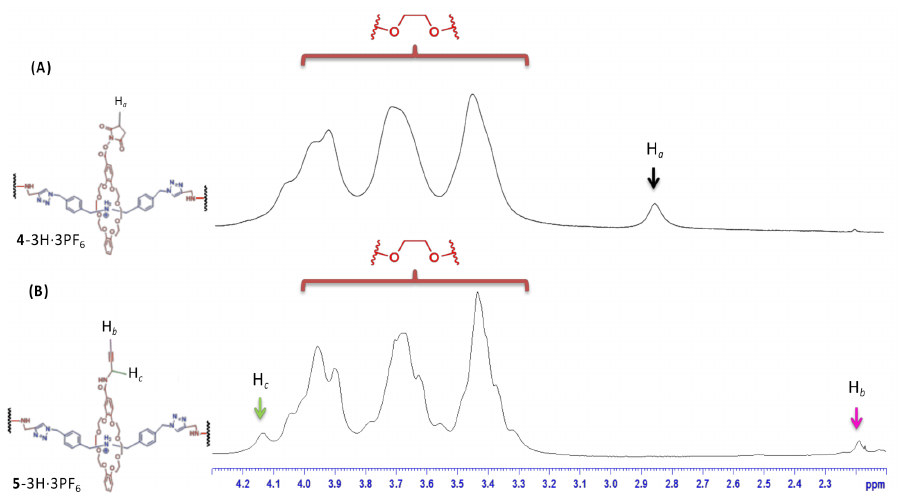
Figure 3. Partial 1 H NMR spectra (2.1 to 4.3 ppm) of G2 rotaxane dendron-OSu 4 -3H · 3PF 6 and ( A ) G2 rotaxane dendron-acetylene 4 -3H · 3PF 6 ; ( B ) G2 rotaxane dendron-acetylene 5 -3H · 3PF 6